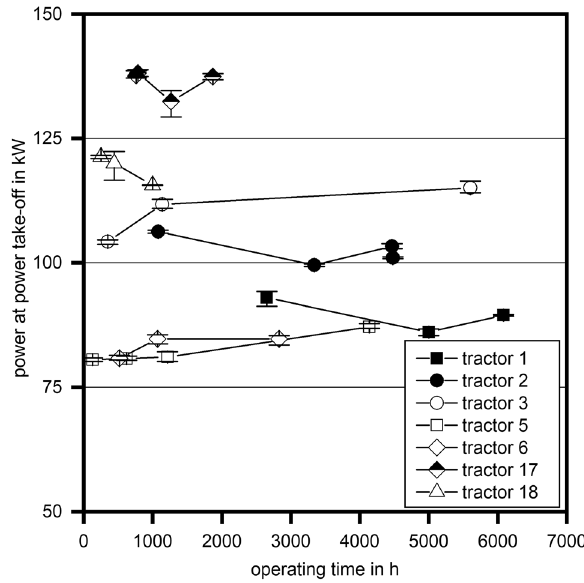
Fig. 6 Power at the power take-off (arithmetic mean and maximum deviation, n = 3) of the tractors at rated speed and full load at dif- ferent operating times with pure rapeseed oil fuel operation